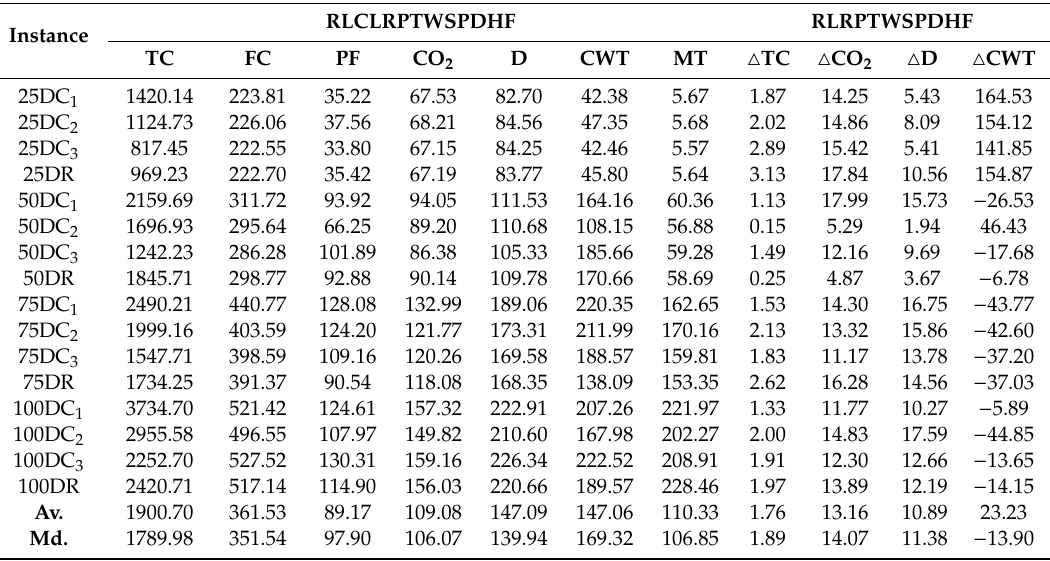
Table 6. Results of two models on LDEPOT.